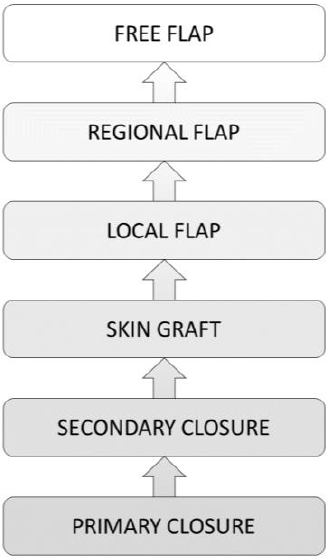
Figure 3. The reconstructive ladder.